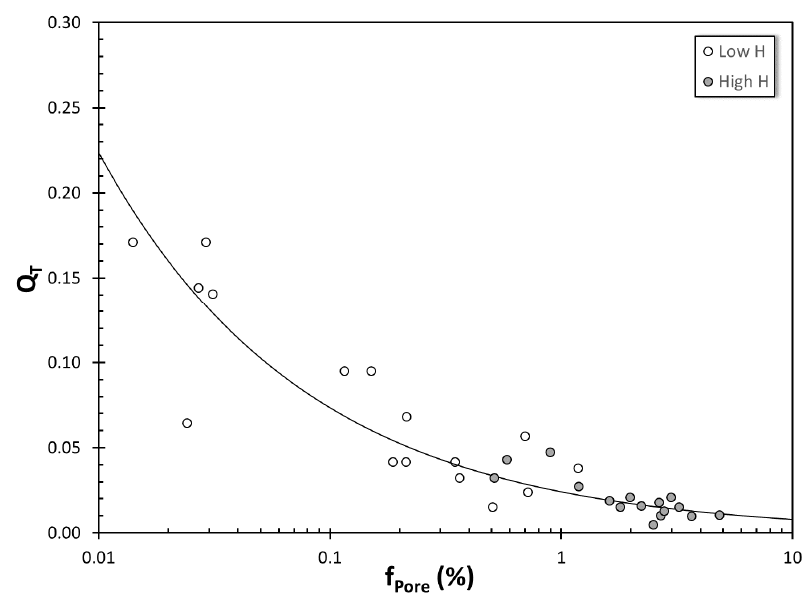
Figure 3. The change in Q T with volumetric pore percentage in 319 datasets (data from